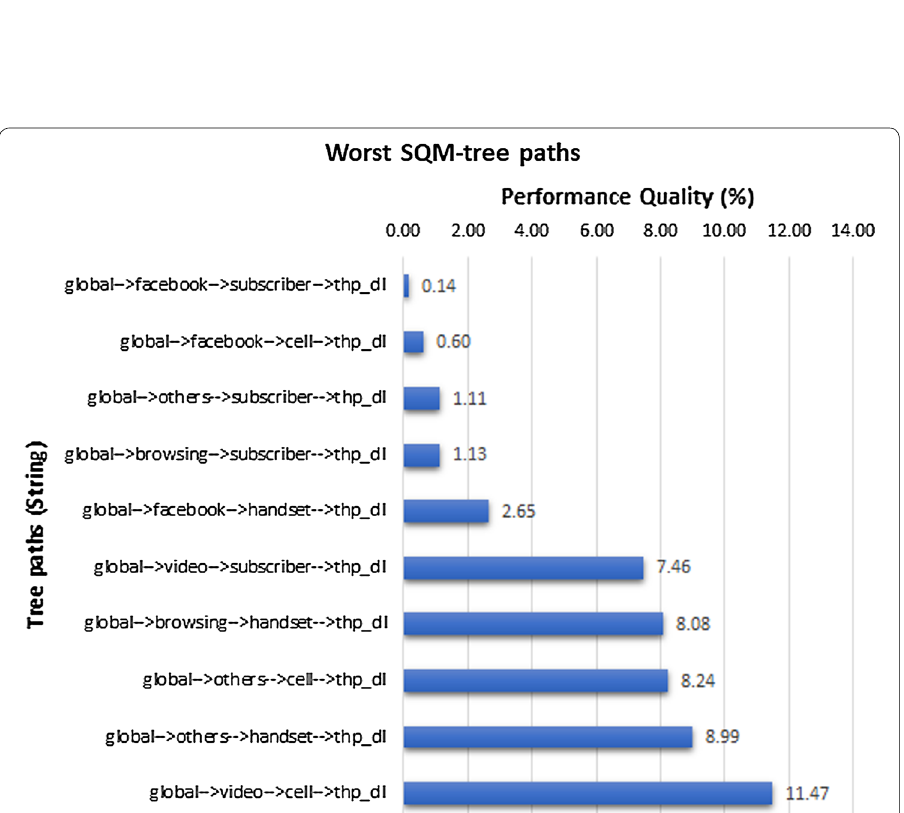
Fig. 6 Ten worst SQM-tree paths: This figure shows the worst SQM tree paths when sorting the performance quality in ascending order. The performance quality is expressed in percentage with the lower value representing the worst performance. In this example the most impacted KPI is the throughput downlink (thp_dl) which affects randomly different dimensions and